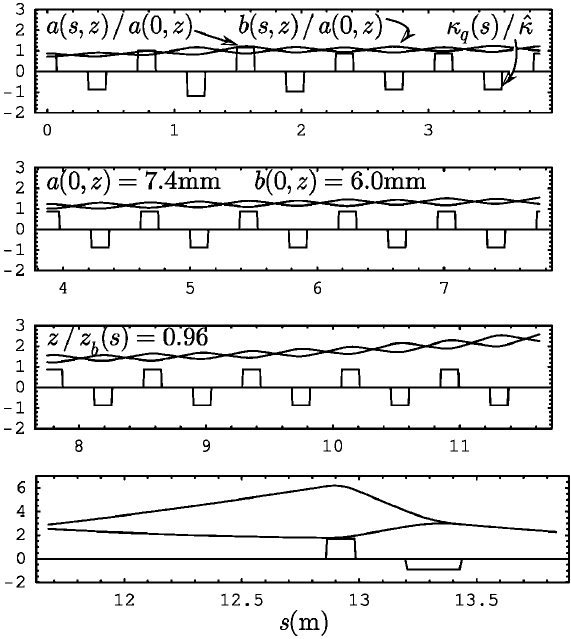
Fig. 7 for a slice near the beam front end with z=z 0 : 96 , where the gradient strength of the 3rd, 4th, 5th, and